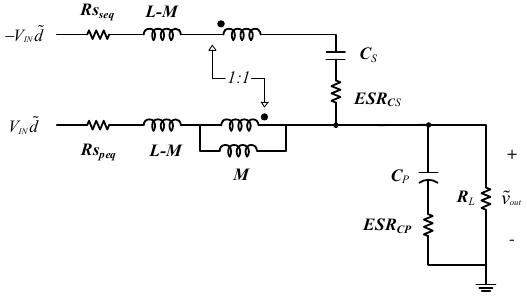
Figure 20. The small-signal model of a stacked buck converter in the form of coupled inductance.